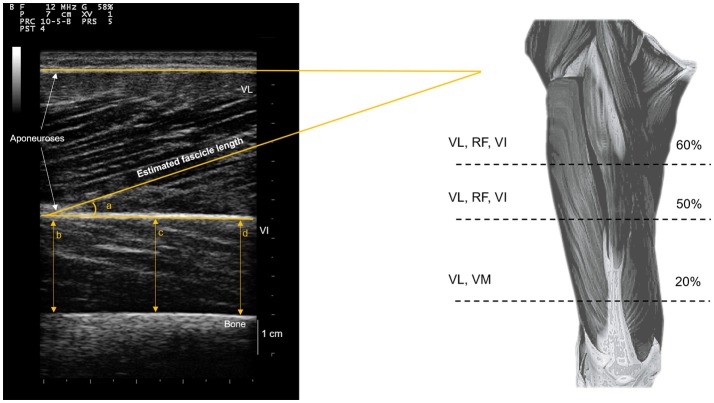
Muscle architecture assessments. Muscle thickness measurements on vastus lateralis (VL), rectus femoris (RF), vastus medialis (VM), and vastus intermedius (VI) were performed at each corresponding measurement location (% thigh length). Muscle thickness VI measurements were performed in the anterior portion, in the same location as RF measurements. Pennation angles and linear estimations of fascicle lengths were averaged across the three VL muscle measurements.